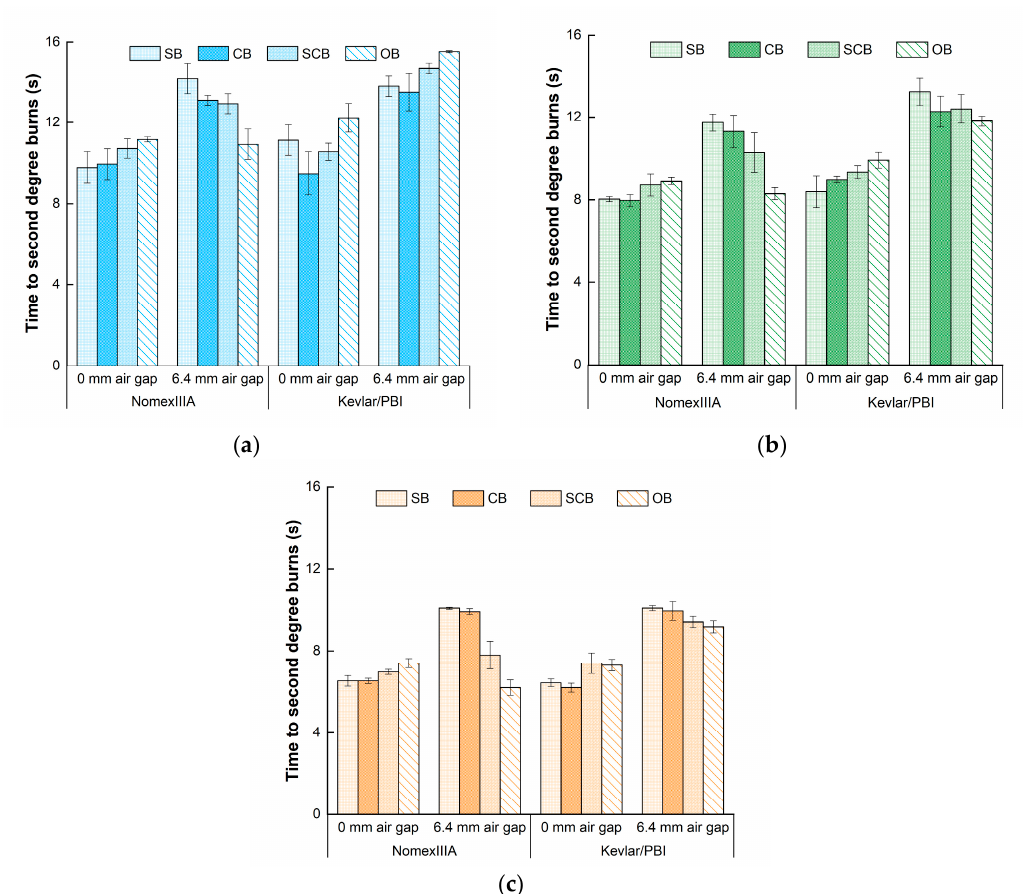
Figure 6. Time-to-second-degree-burns under the heat flux of: ( a ) 30 kW/m 2 ; ( b ) 40 kW/m 2 ; ( c ) 50 kW/m 2 . SB—standard boundary; CB—confined boundary; SCB—semiconfined boundary; OB—open boundary. One-way analysis of variance indicated significant e ff ects of air gap ( p < 0.001) and heat-flux level ( p < 0.001). Time-to-second-degree-burns for 6.4-mm air gap was significant—greater